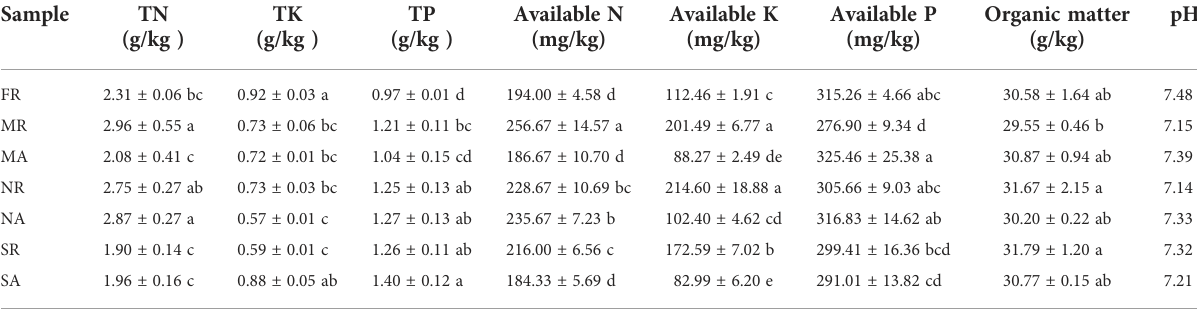
TABLE 1 Content of soil under different planting